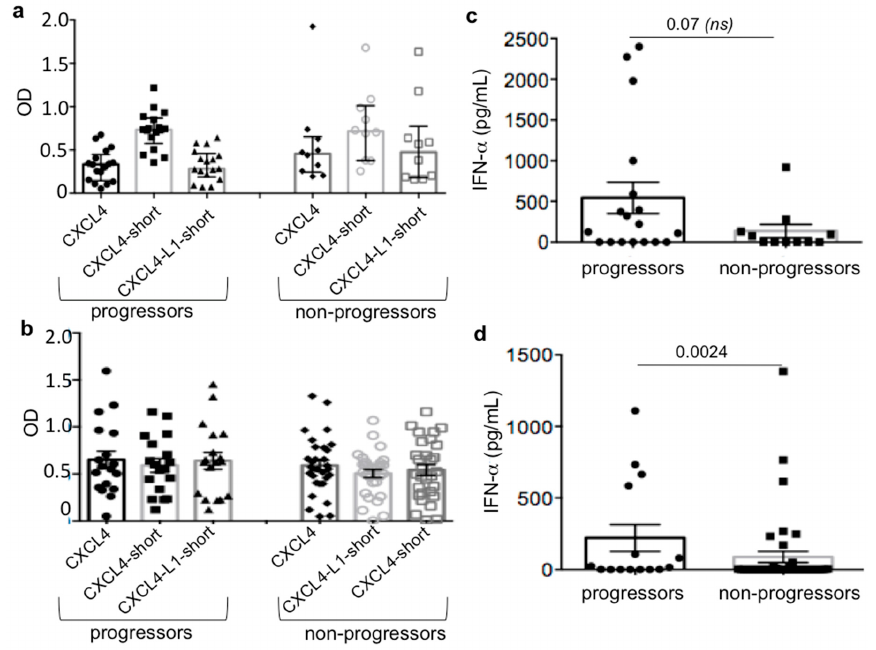
Figure 4. Anti-CXCL4/CXCL4-L1 autoantibodies do not discriminate SSc-progressors from SSc-non-progressors among VEDOSS. ( a , b ) Plasma of VEDOSS patients, divided in progressors and non-progressors, were tested for antibody reactivity to entire CXCL4 (CXCL4) or to the 27 mer peptides spanning the COOH-term of CXCL4 (CXCL4-short) or CXCL4-L1 (CXCL4-L1-short), by ELISA in the discovery VEDOSS cohort ( a ), and in the replication VEDOSS cohort ( b ). Results are reported as optical density (OD). ( c , d ) IFN-a was tested in plasma of VEDOSS patients of the discovery ( c ) and replication ( d ) cohort by ELISA. In the graphs, amounts of IFN-a are reported in comparison for progressors and non-progressors. In all graphs horizontal bars represent the means, vertical bars are standard error of the mean (SEM); p values by Mann–Whitney test.